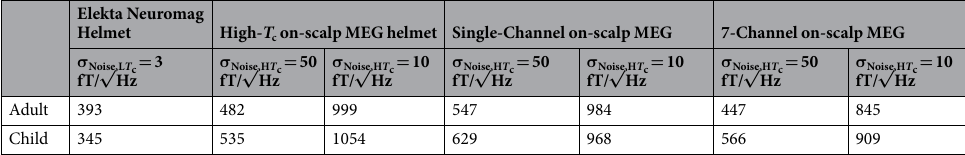
Table 1. Total information capacity in bits per sample for each sensor array and